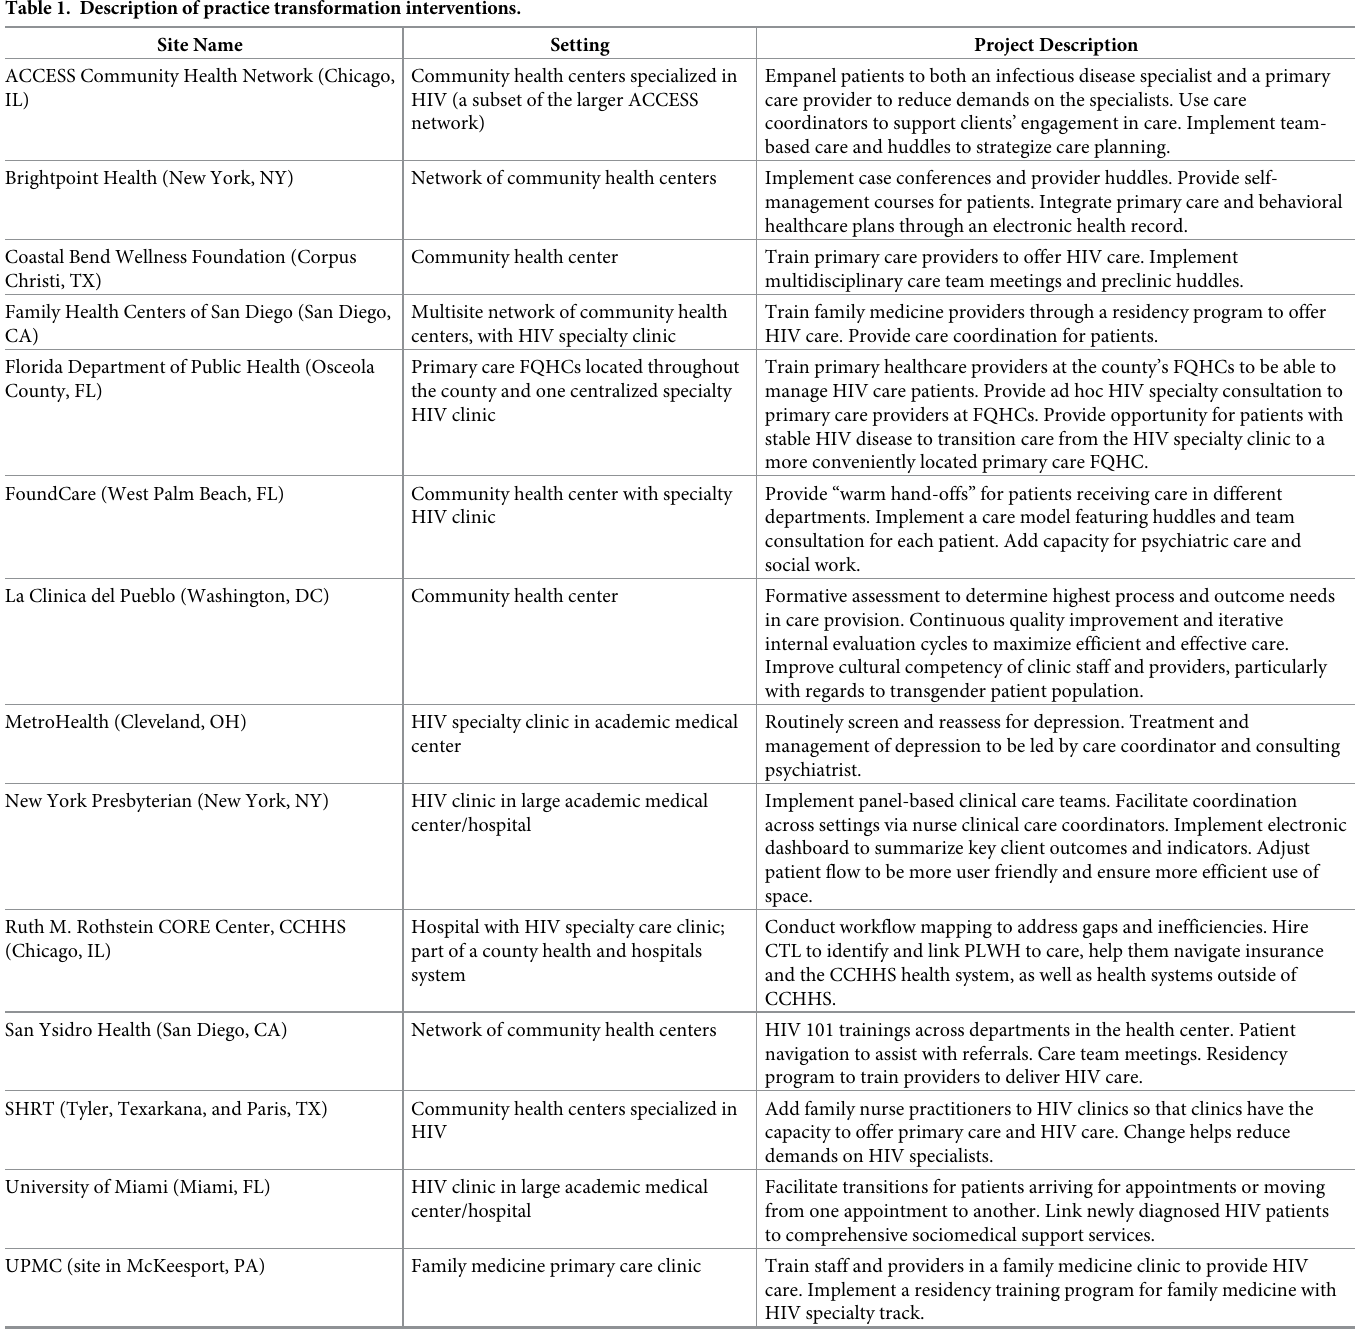
Table 1. Description of practice transformation